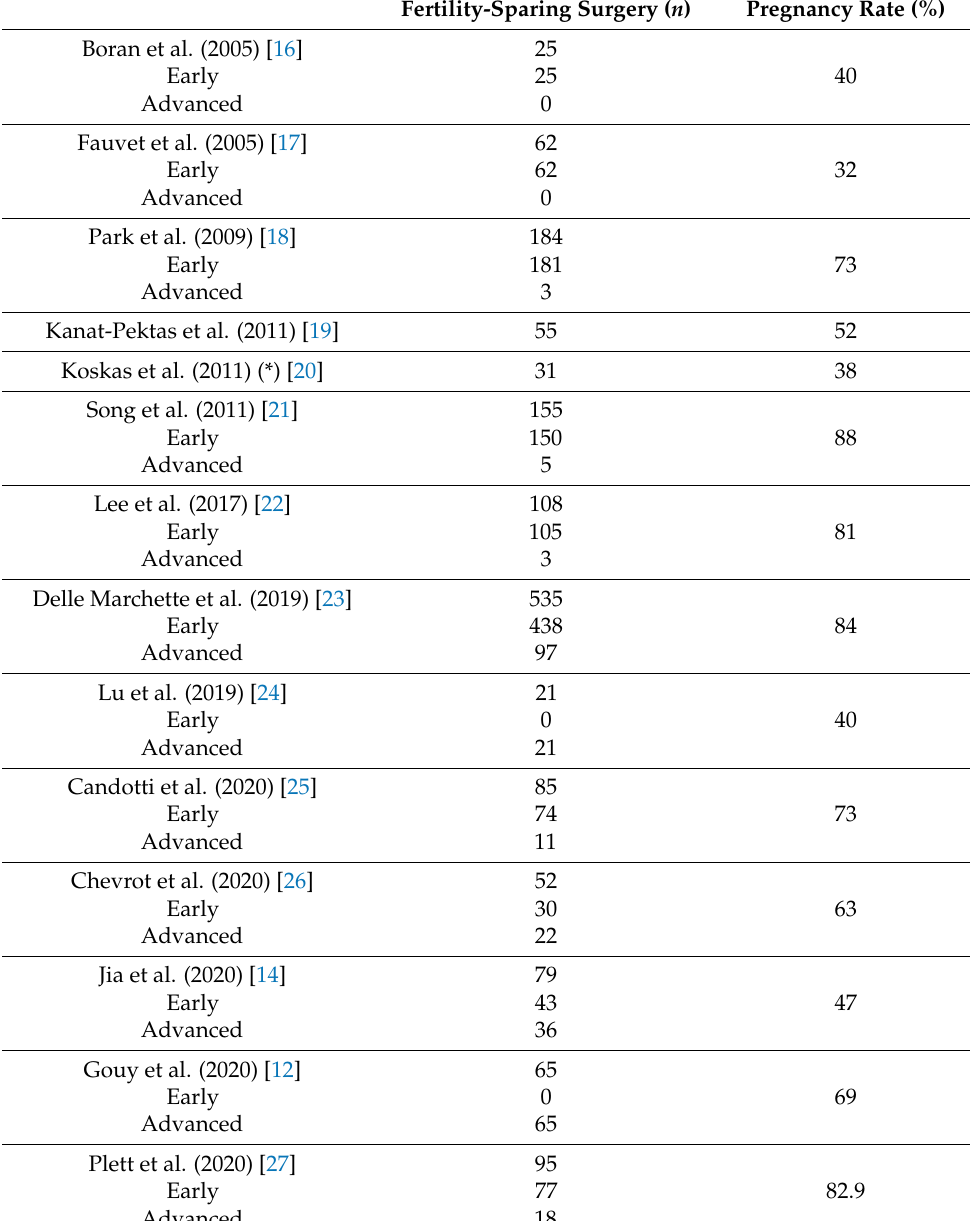
Table 1. Fertility results after fertility-sparing surgery in series of women with borderline ovarian tumors and a desire to